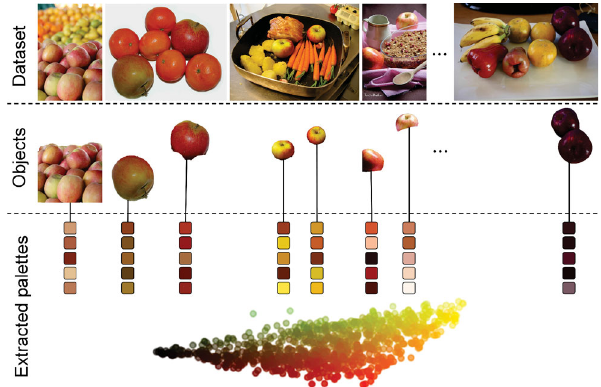
Fig. 1 Example of our palette extraction process. For the category “apple”, we first extract apples from images, and then calculate their palettes